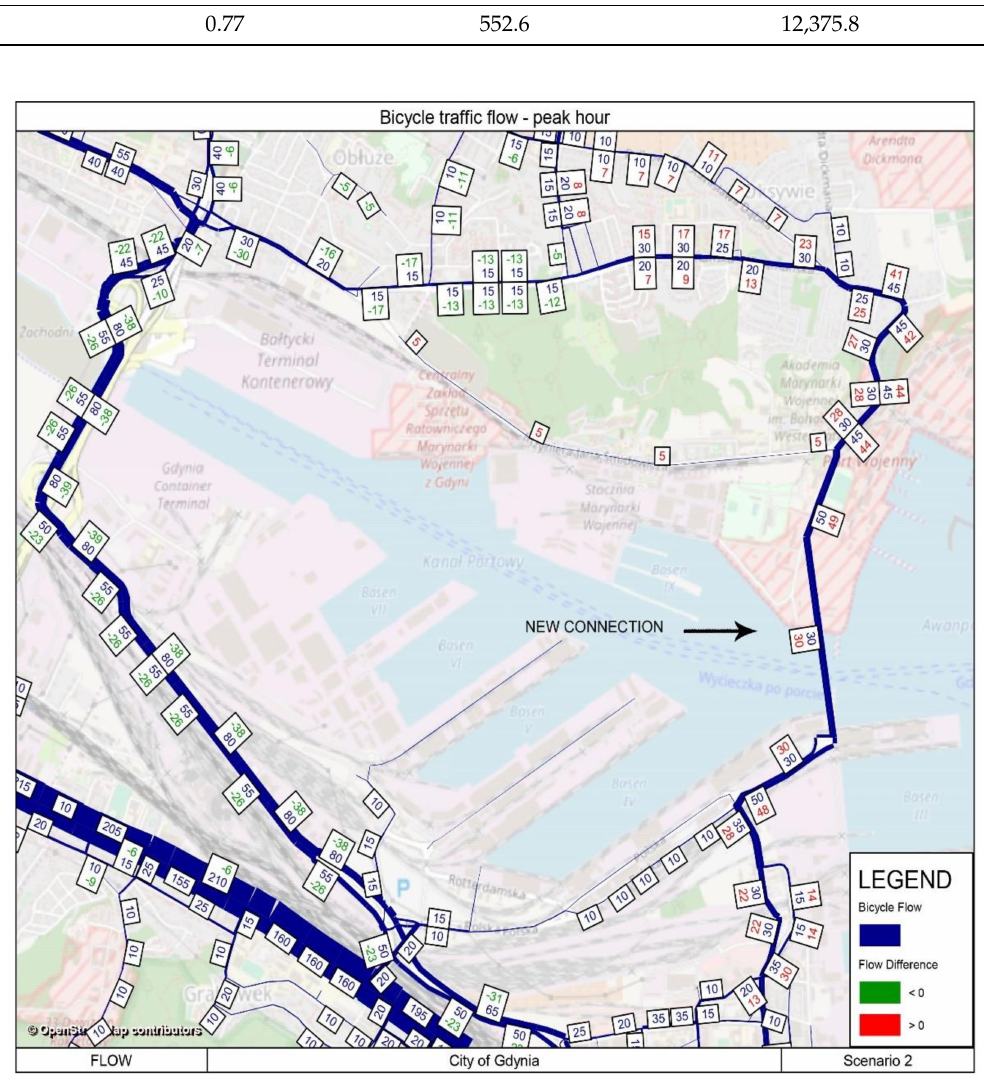
Figure 7. Bicycle traffic volumes in Scenario 2, and comparison of values with the baseline